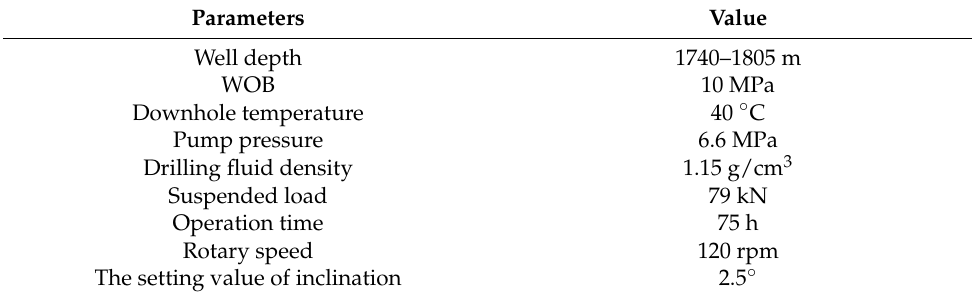
Table 4. Basic parameters of the field-drilling test.